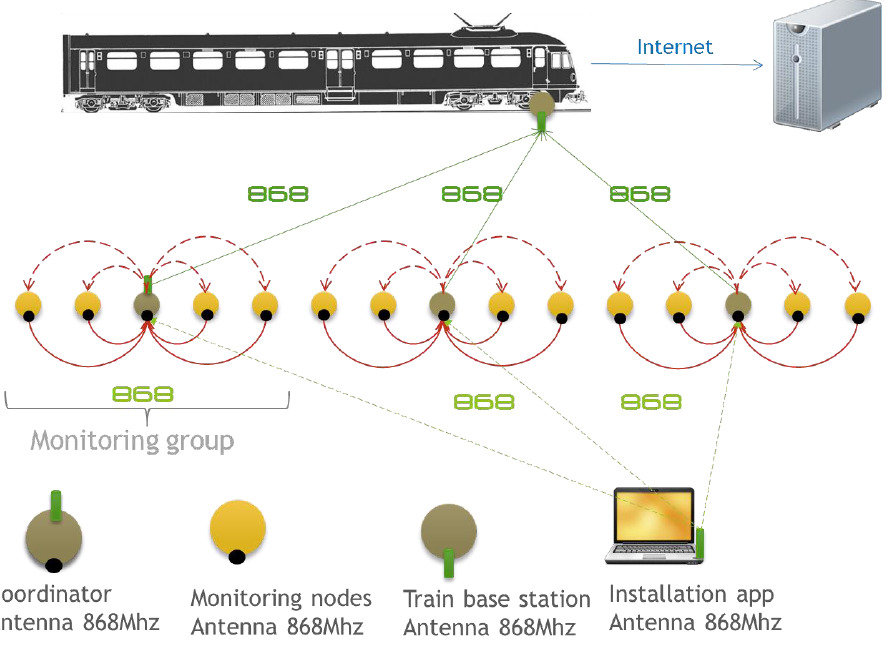
Figure 1. Sensor4PRI